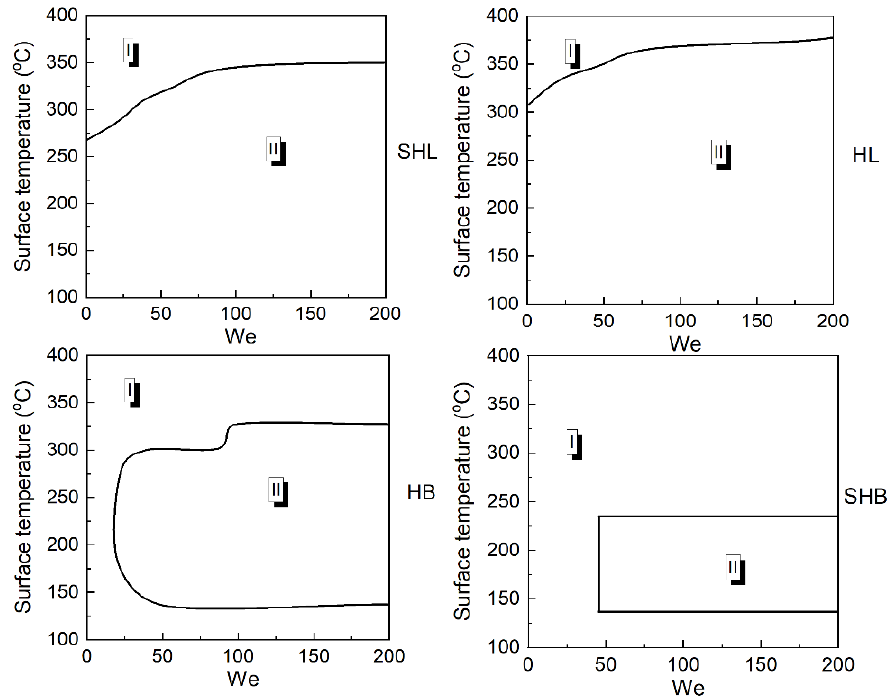
Figure 7. Wall impact regime map plotted using the data from [64]. I—secondary fragments are not formed; II—secondary droplets are formed. HL is hydrophilic surface; SHB denotes superhydrophobic surface; HB stands for hydrophobic surface.